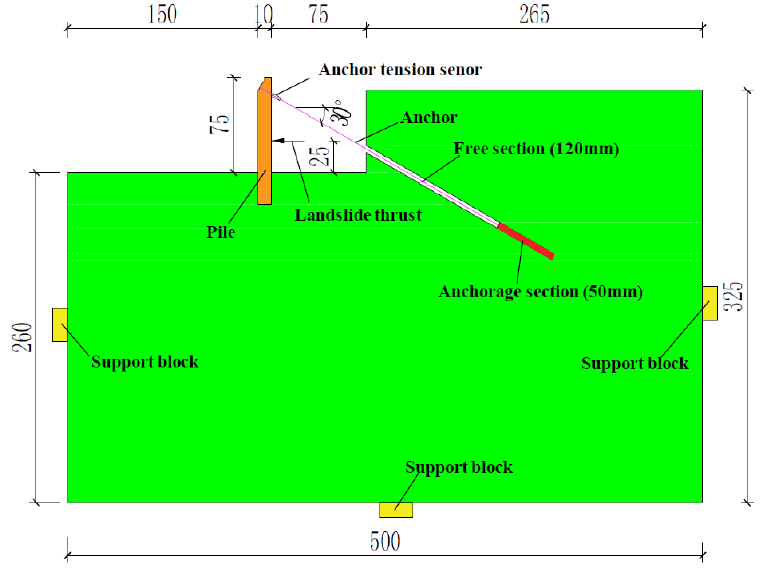
Figure 1. Experimental setup. ( a ) Flow chart of test, ( b ) schematic of physical landslide model.